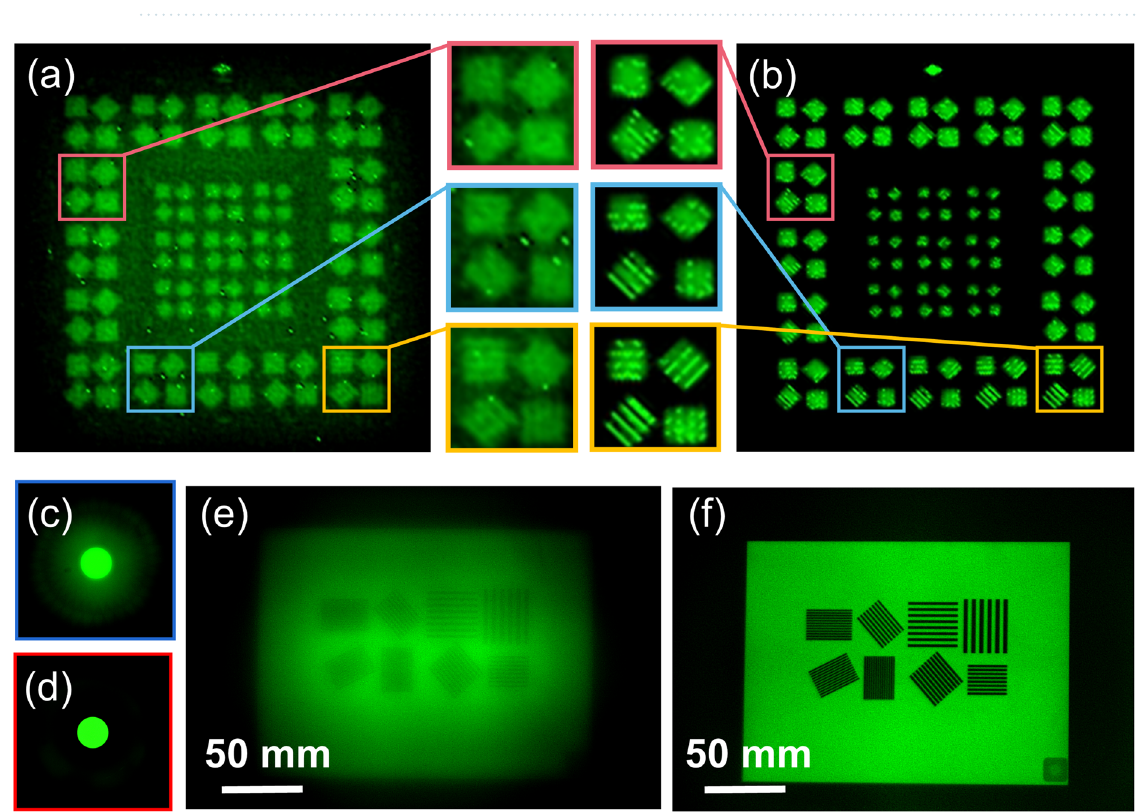
Figure. 6. Imaging quality testing of the short focus. ( a ) Resolution image taken by the FZP. ( b ) Resolution image taken by the BDL. ( c ) Focal spot at short focal plane of the FZP. ( d ) Focal spot at short focal plane of the BDL. ( e ) Actual object image taken by FZP. ( f ) Actual object image taken by the